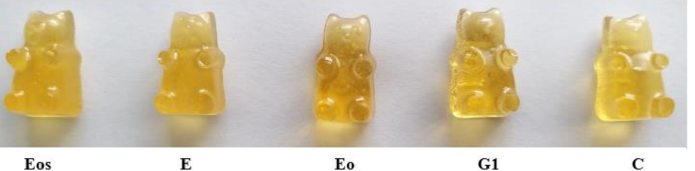
Figure 1. Chewable gel tablets’ (Eos, E, Eo, G1, C) color pallet. The chewable tablets’ composition code is given in Table